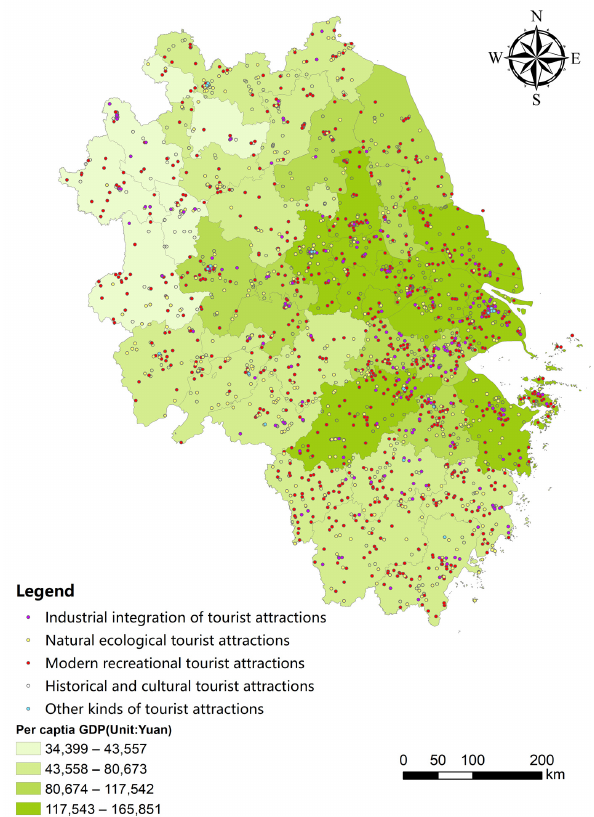
Figure 8. The coupling between social economy and the distribution of tourist attractions.